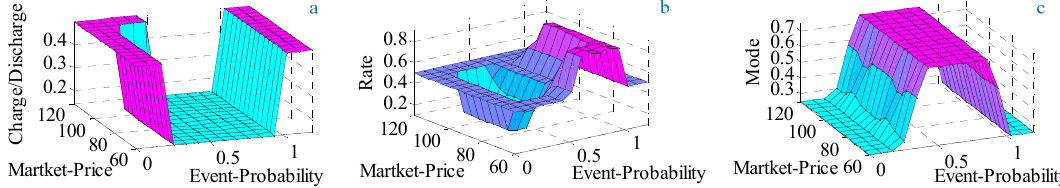
Figure 7. Control surfaces for BESS operation controller corresponding to event occurrence probability and BESS SOC: ( a ) charging/discharging mode; ( b ) charging/discharging rate; ( c ) BESS operation mode.